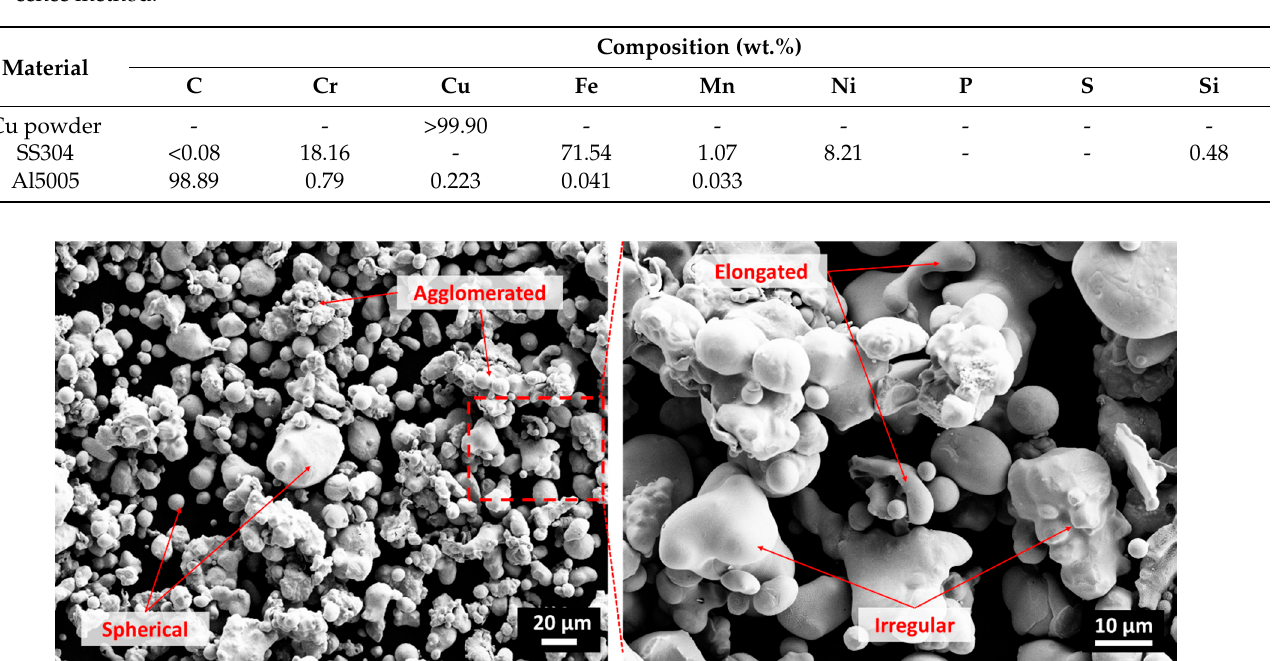
Table 2. Chemical composition of copper powders, stainless steel plate, and aluminum plate, measured by X-ray fluores- cence method.